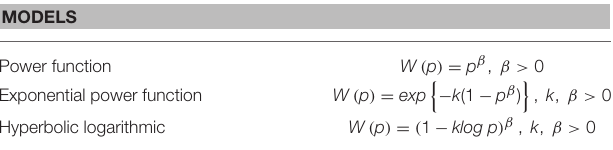
TABLE 8 | List of models.